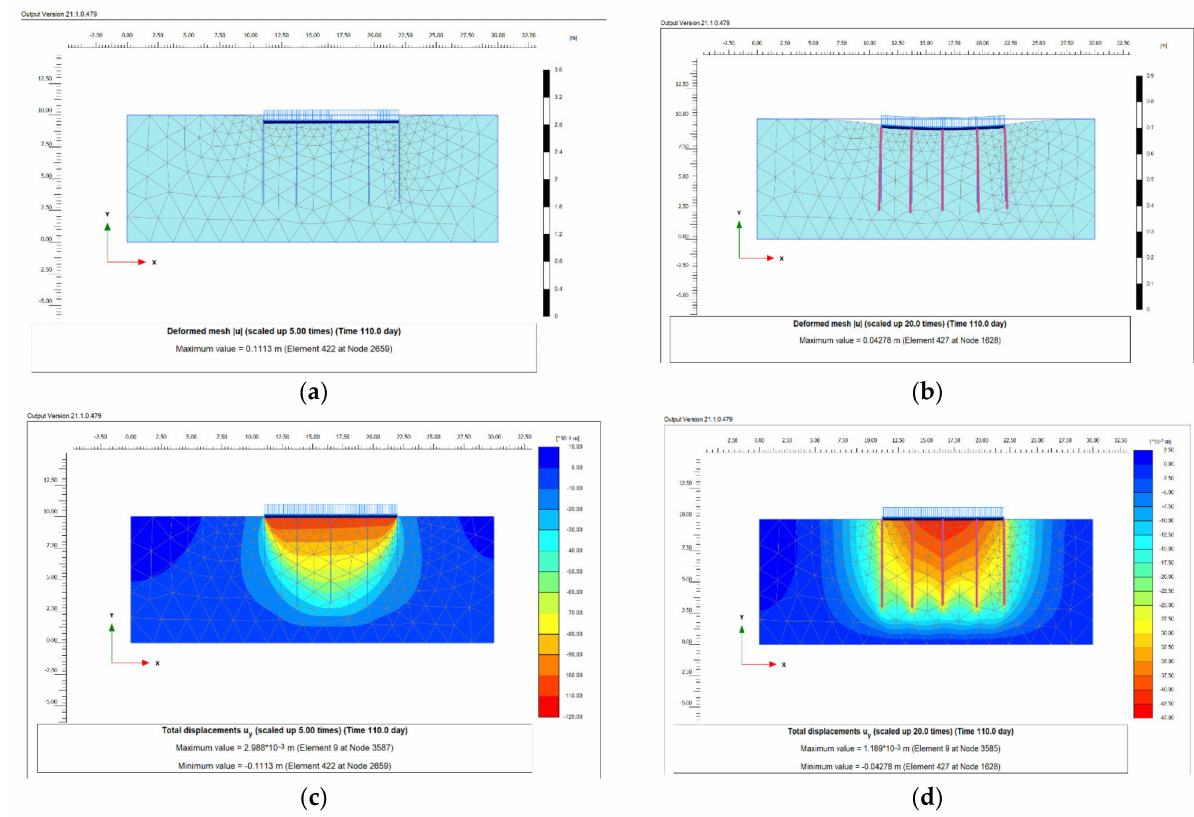
Figure 8. 200 kN/m 2 and raft and pile raft: ( a ) deformed mesh of raft, ( b ) contours of displacement raft, ( c ) deformed mesh piled raft, and ( d ) contours of displacement piled